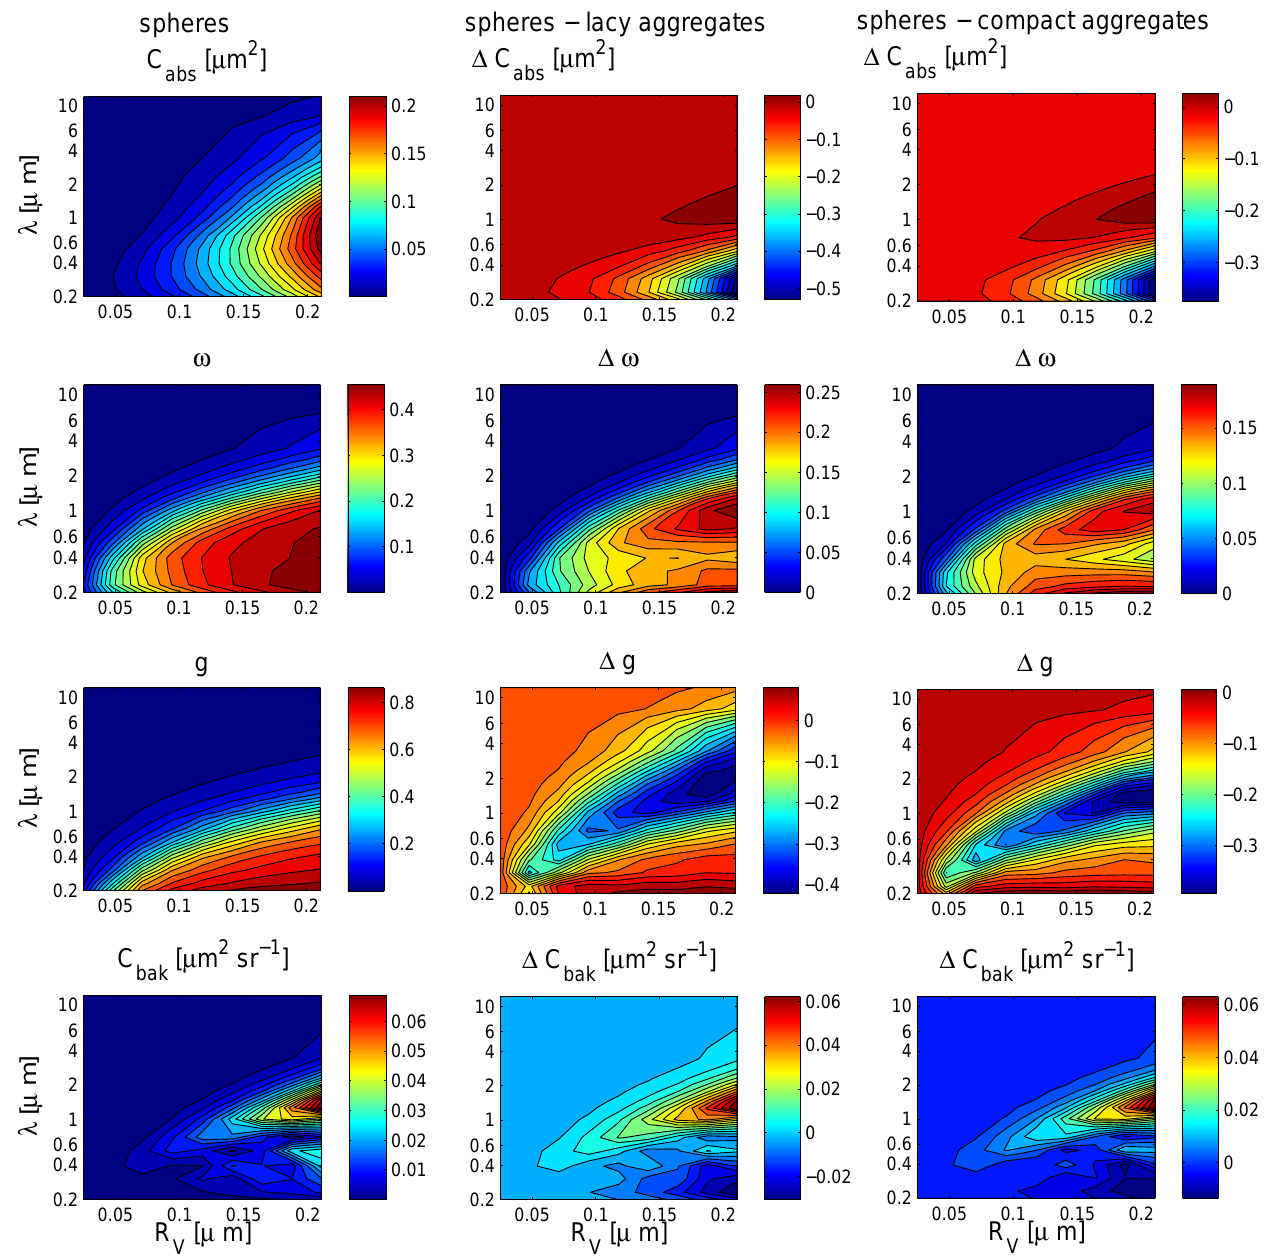
Fig. 2. Left column: optical properties of homogeneous spheres as a function of size R V and wavelength λ . Middle column: difference in optical properties between spheres and lacy aggregates. Right column: difference in optical properties between spheres and compact aggregates. The four rows show C abs , ω , g , and C bak ,